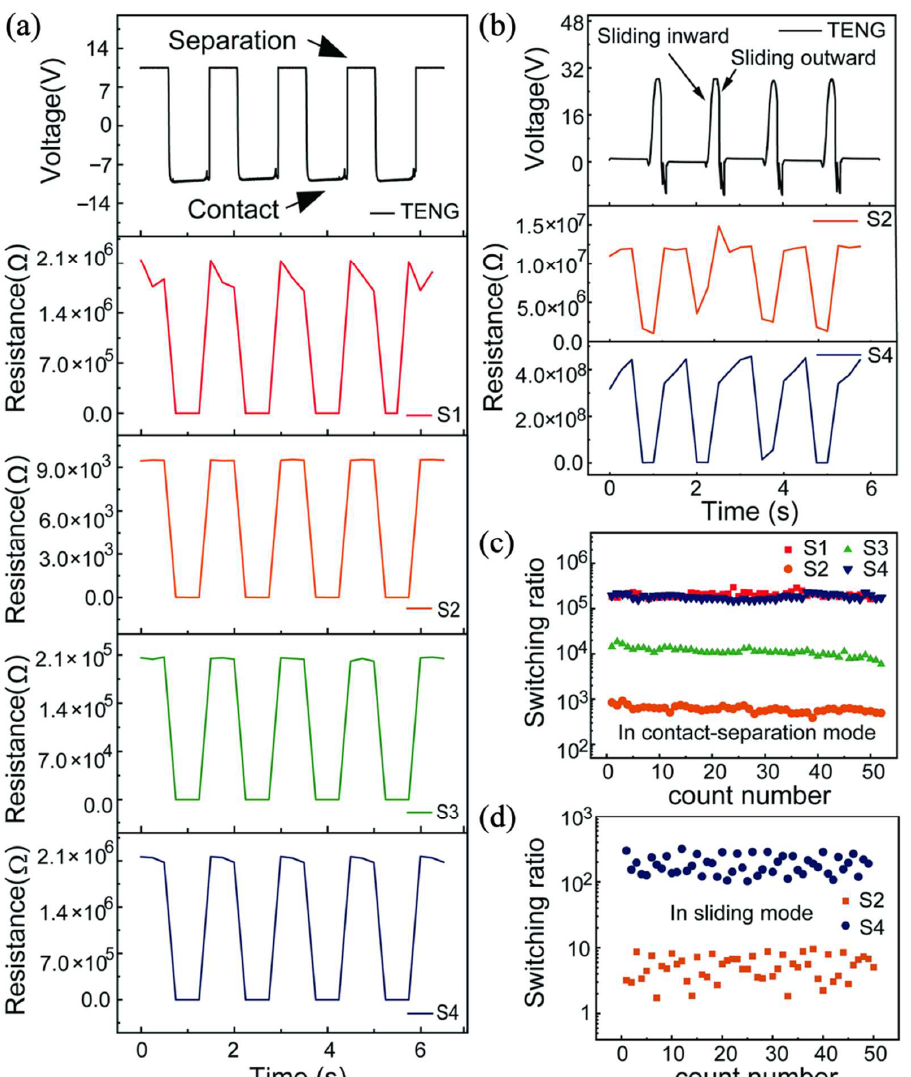
Figure 4. RS in an Ag/PCMO/Pt cell at room temperature. By applying voltages from TENG, the resistance of the cell changes reversibly between HRS and LRS. ( a ) RS characteristics of four samples based on contact mode TENG. ( b ) RS characteristics curves of samples S2 and S4 based on sliding mode TENG. ( c ) Endurance of switching behavior in the contact-separation mode. ( d ) Endurance of switching behavior in the sliding friction